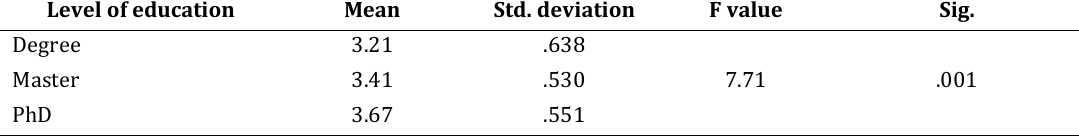
Table 5: The difference between level of education and awareness of Shariah-based PRS Level of education Mean Std. deviation F value Sig. Degree 3.21 .638 PhD .551